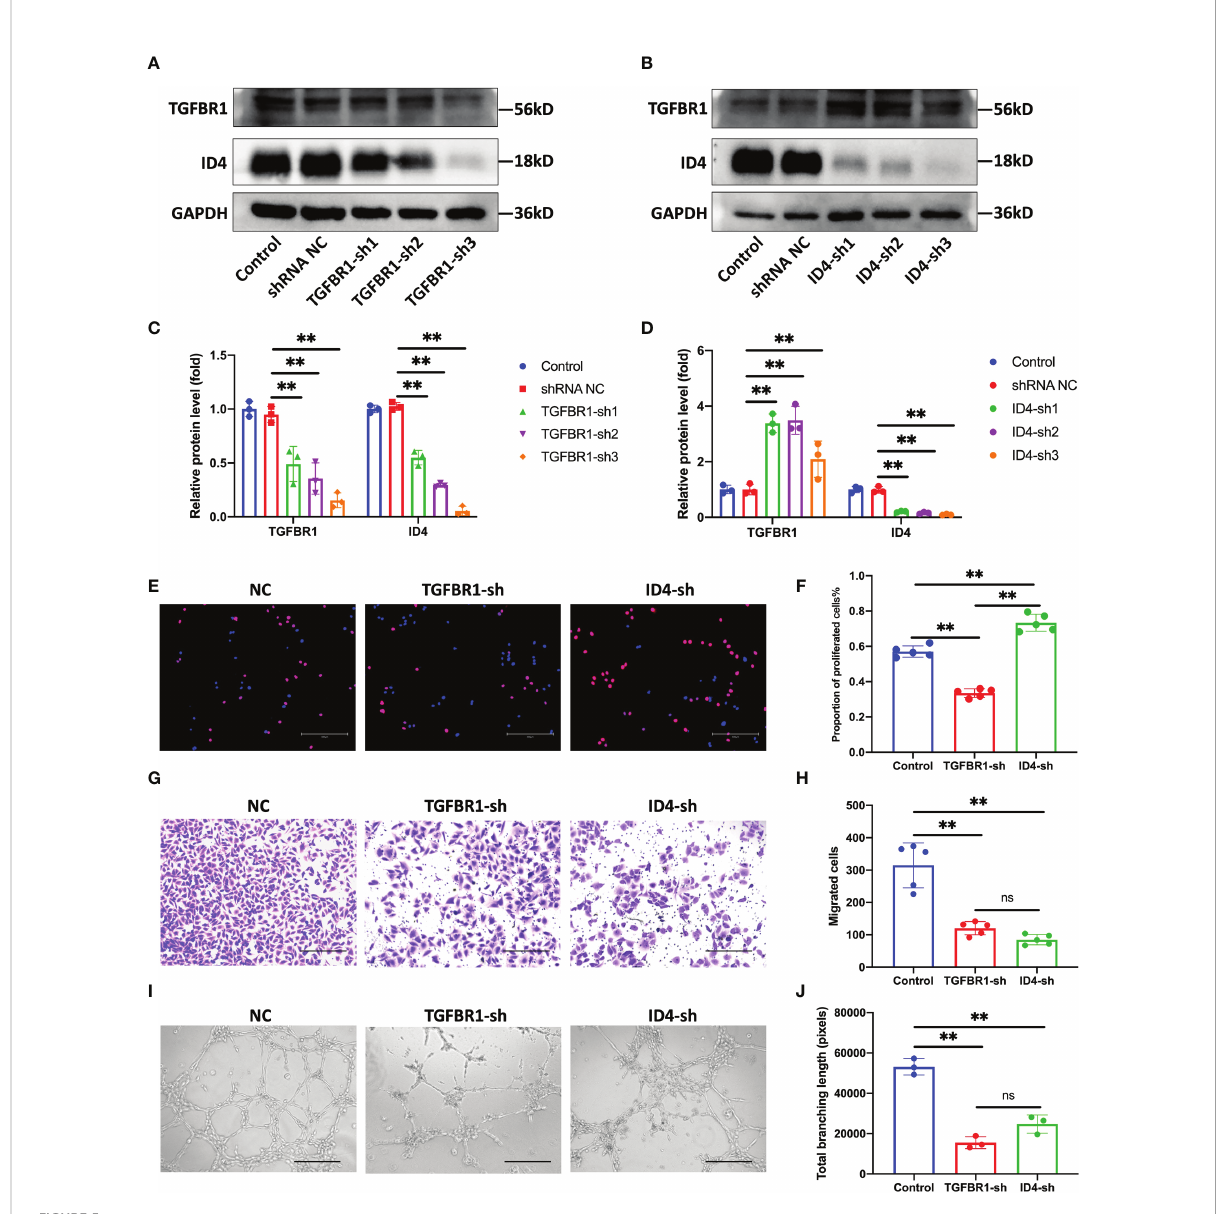
FIGURE 5 Knock down of TGFBR1 and ID4 regulates the angiogenic ability of ECs. (A, C) Representative bands showing the of levels of the TGFBR1 and ID4 protein in control, shRNA NC and TGFBR1-sh1-3 HUVECs (A) . The relative TGFBR1 and ID4 protein levels were normalized to those of GAPDH (C) . (B, D) Representative bands showing the levels of the TGFBR1 and ID4 proteins in control, shRNA NC and ID4-sh1-3 HUVECs (B) . The relative TGFBR1 and ID4 protein levels were normalized to those of GAPDH (D) . (E, F) Representative images of EdU staining and the proportions of proliferating cells in NC, TGFBR1-sh and ID4-sh HUVECs. Scale bar: 300 m m. (G, H) Representative images of the transwell assay and the proportions of migrating cells in control, TGFBR1-sh and ID4-sh HUVECs. Scale bar: 300 m m. (I, J) Representative images of the tube formation assay and the total branching length of control, TGFBR1-sh and ID4-sh HUVECs. Scale bar: 300 m m. **P < 0.01. ns, not signi fi cance. All data are presented as the means ± standard deviation. Statistical signi fi cance was determined using unpaired, 2-tailed Student ’ s t